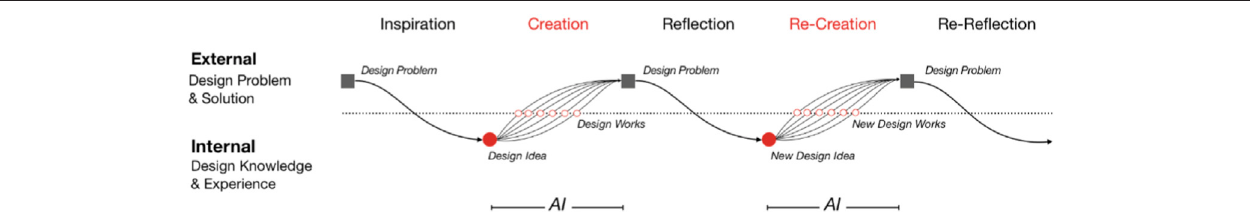
FIGURE 2| The AI-augmented creative design cycle as described by Zeng et al. (2019). The authors describe how AI can be used to augment the design process byintroducingvarietytotheusers ’ input,allowingthemtoquicklyexpandtheirsolutionspace.Thecorecreativedesigncycleofcontinuousinteractionbetweencreation and re fl ection remains